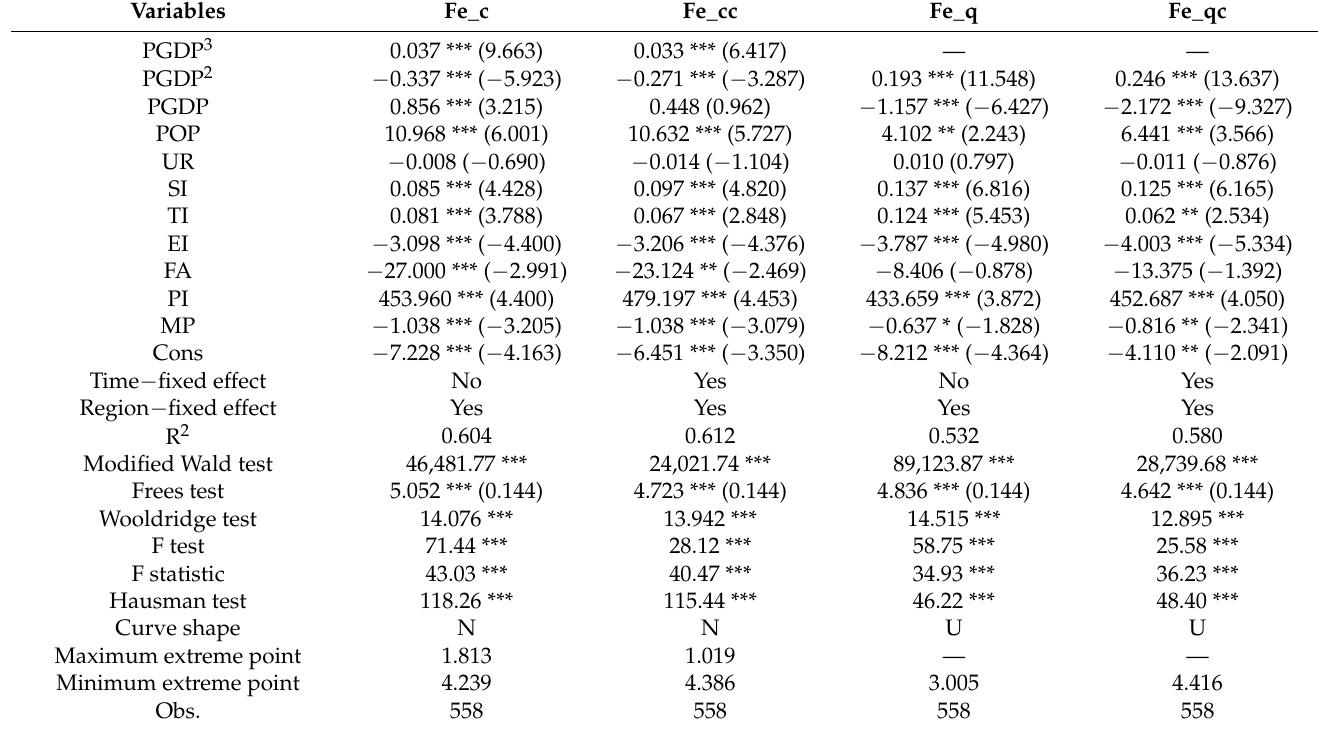
Table 6. The results of basic